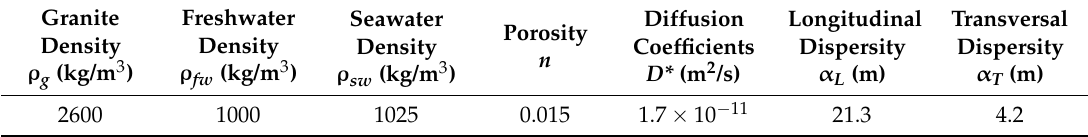
Table 2. The model